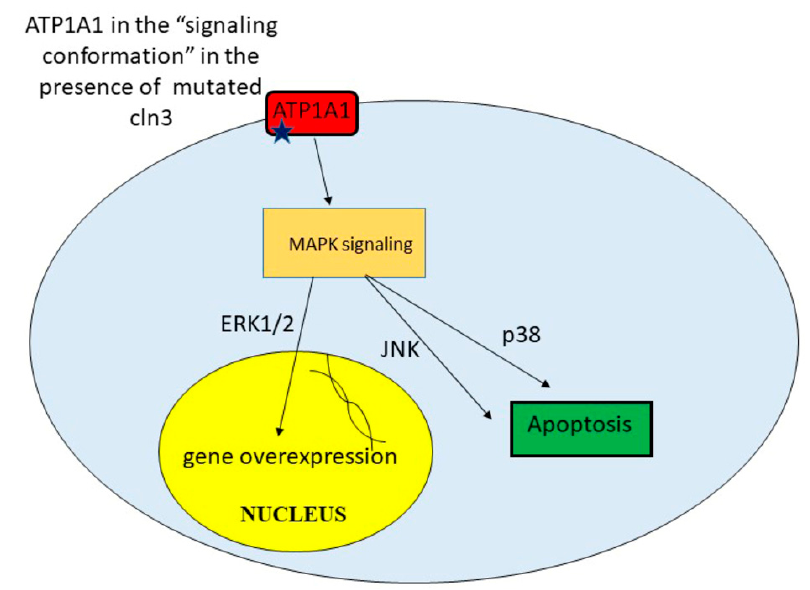
Figure 3. Processes activating in cln3 − cells in presence of unregulated signaling cascades.